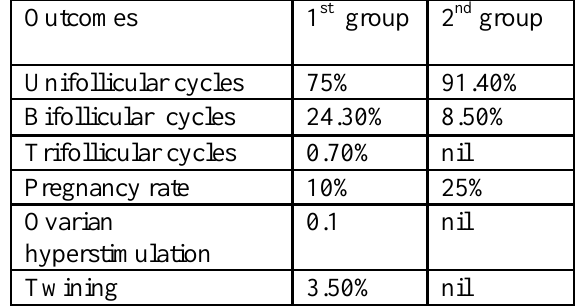
Table-7 Comparison between the outcomes of